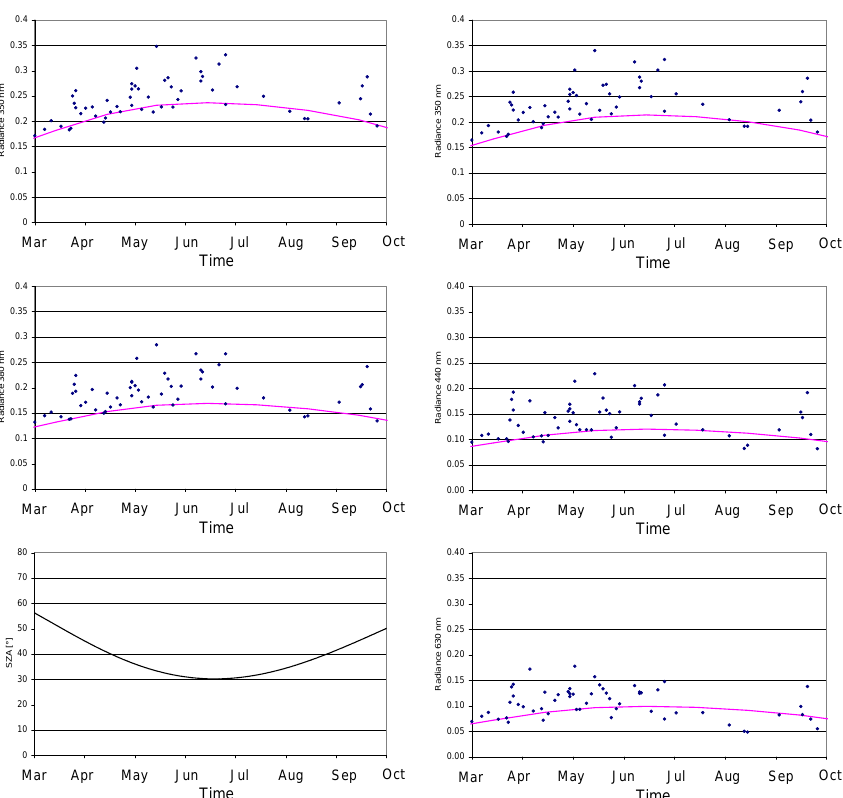
Fig. 6 Seasonal variation (March to October) of the normalised radiances over Beijing. The measurements include only cloud-free observations. The magenta lines represent the result of radiative transfer simulations (see Sect. 3) for aerosol-free conditions. Also shown is the seasonal variation of the SZA (lower left panel). For 630 nm the surface albedo was set to 10%; for all other wavelengths it was set to 5%.